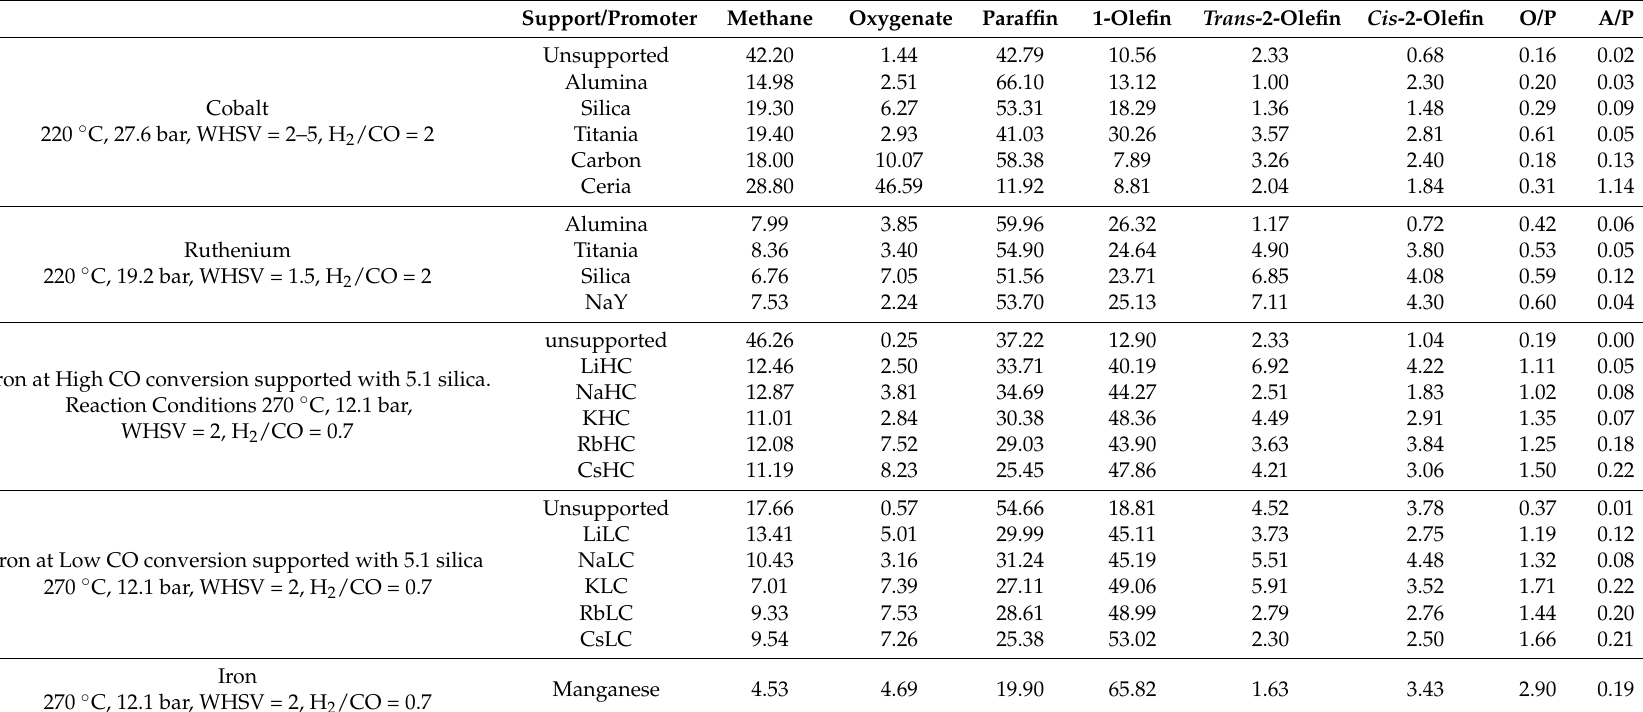
Table 2. Product Distribution in moles of